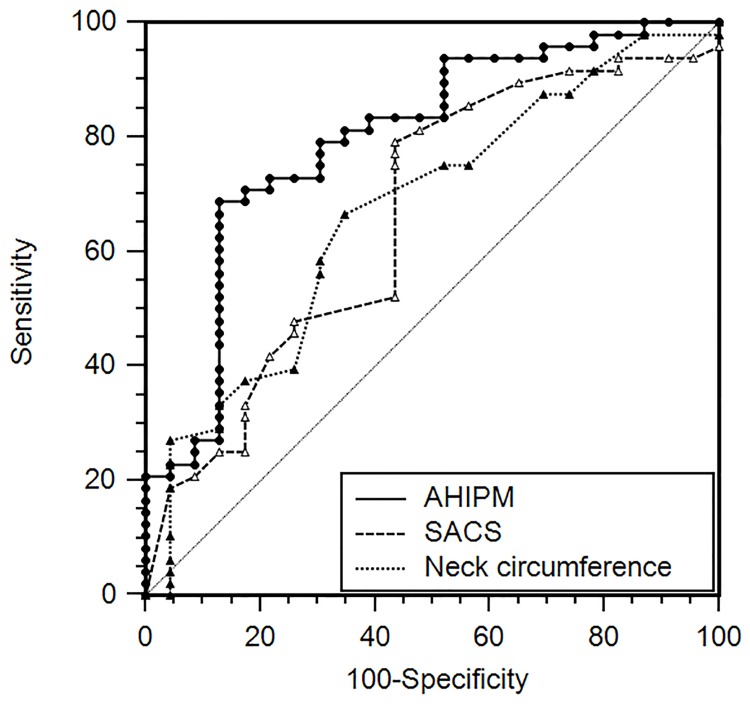
Receiver operating characteristic curve for AHIPM, Sleep Apnea Clinical Score, and neck circumference for predicting AHIPSG ≥ 15.The areas were similar for the three predictors.